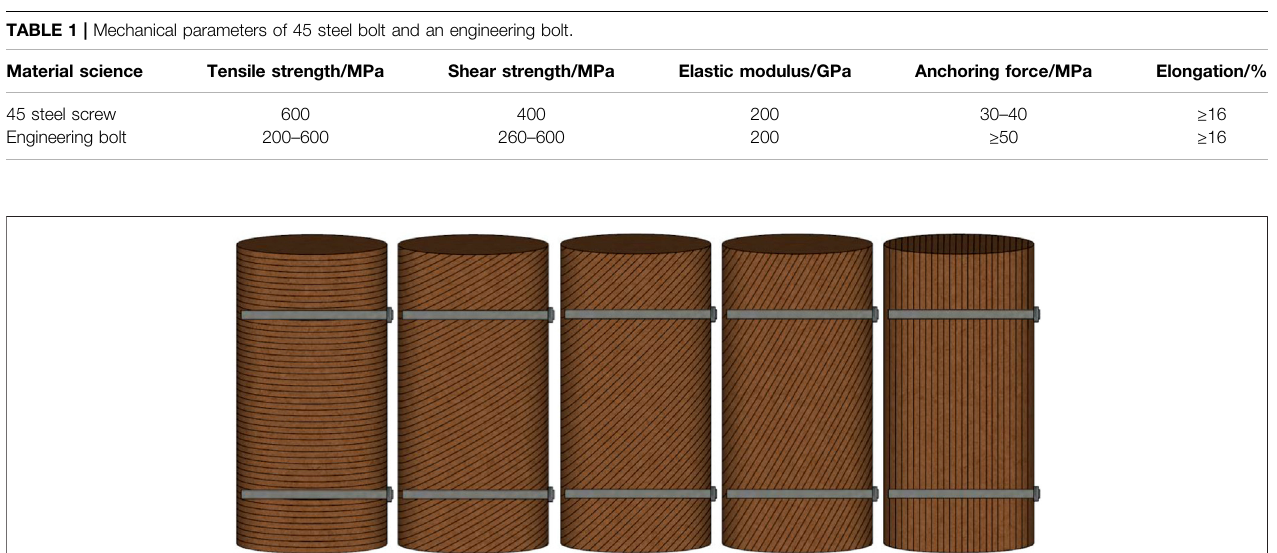
( Figure 2 ) was used to measure the wave velocity of each rock sample three times at different positions at both ends of each sample, before taking the average value, having eliminated outliers.